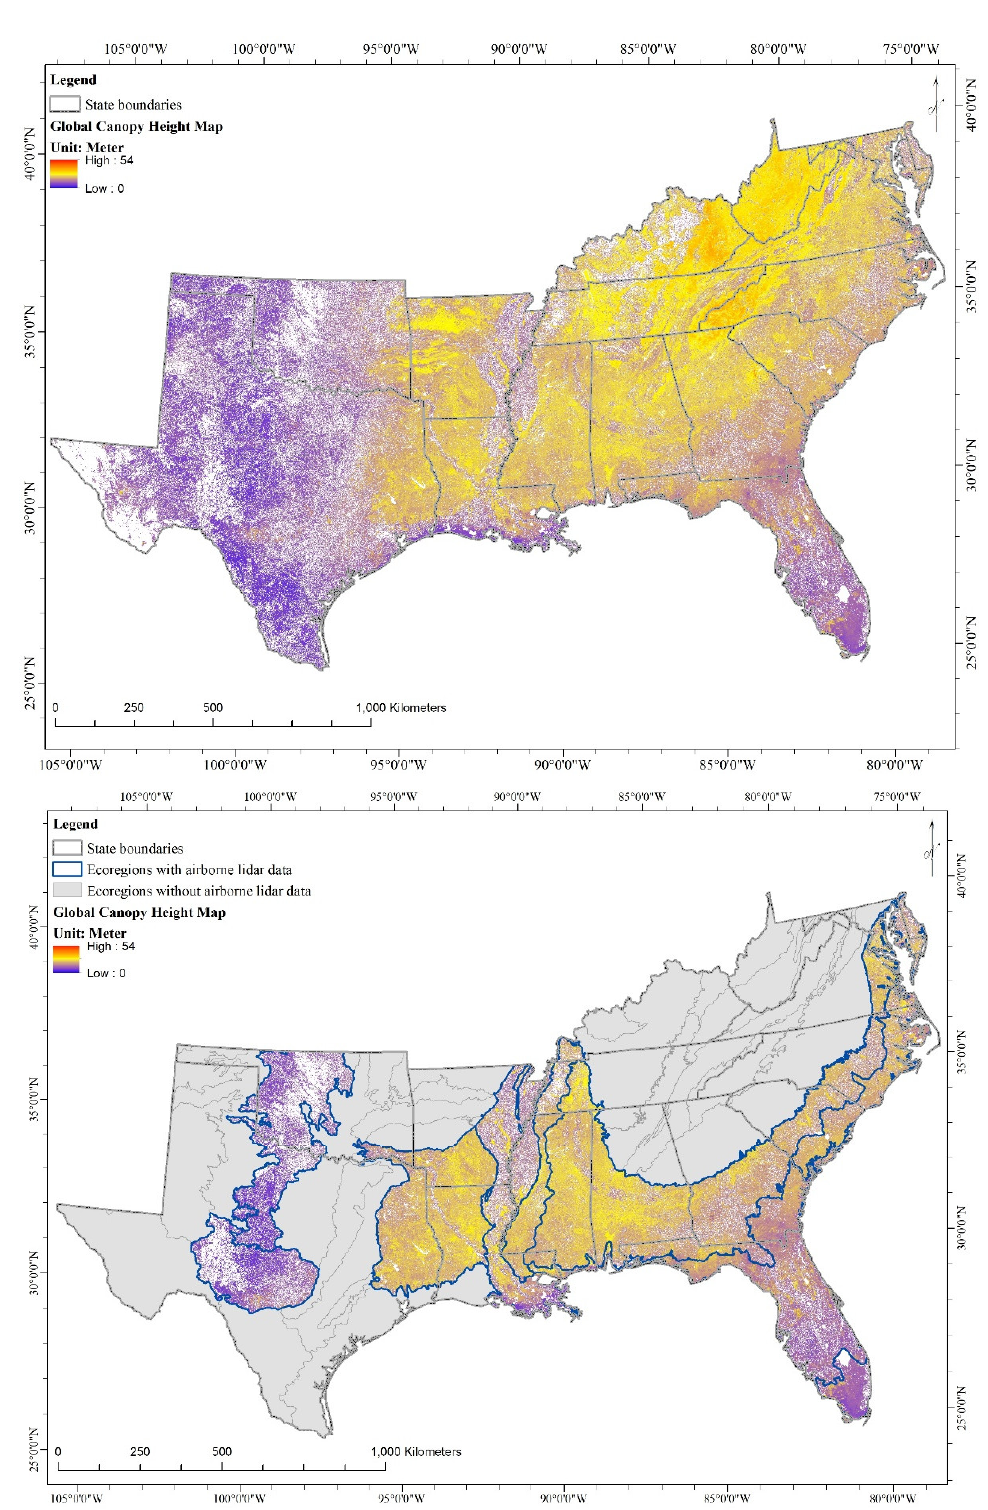
Figure 3. Top panel, simGCHM (Simard et al. [12]) restricted to the southern United States. EPA level III ecoregions [20]; bottom panel, simGCHM restricted to the nine EPA ecoregions used in this study. The recalibration approach adopted herein was used to rescale existing map values to a particular region, through the use of local, better resolution (and, presumably, better quality) data. As such, the cell size of the selected map product, not the initial data from which that map was derived, determined the nominal resolution of the recalibrated map. Simard et al. [12] used 1 km 2 pixels; Lefsky [11] used forest patches which ranged from about 0.25 km 2 to 225 km 2 , with a mean of about 25 km 2 globally. Simard et al. [12] (p.1) provided a convincing argument in favor of their 1 km 2 pixels over the lefGCHM patches. Consistently sized pixels, such as those of simGCHM, may also be more consistent with regression analyses, if long runs of gridded, like-valued, and patch-based attributes were to be observed. Finally, while both Simard et al. [12] and Bolton et al. [15] provided the caveat that differences in methodologies need to be considered when comparing lefGCHM and simGCHM, both papers found simGCHM to be superior to lefGCHM. In short, we chose simGCHM (Figure 3) as our reference GCHM, due to its proper spatial resolution, the large forest areas that it covers, visual agreement with the EPA level III regions, and its public availability on the NASA Jet Propulsion Laboratory website (Global 1 km Forest Canopy Height) [37]. 2.3. The Airborne Lidar Data Existing airborne lidar data from publicly available sources were used for this re- search. Sources included: (1) NASA’s Goddard’s LiDAR, Hyperspectral, and Thermal Im- age (G-LiHT) program [38]; (2) the National Ecological Observatory Network’s (NEON) prototype data sharing program [39]; (3) the NSF OpenTopography program [40]; and (4) the Lidar Applications for the Study of Ecosystem with Remote Sensing (LASERS) Labor- atory, Department of Ecosystem Science and Management, Texas A&M University. The scanning locations of these airborne lidar collections were distributed (albeit not ran- domly nor evenly) throughout the study area. They included sites in Alabama, Arkansas–